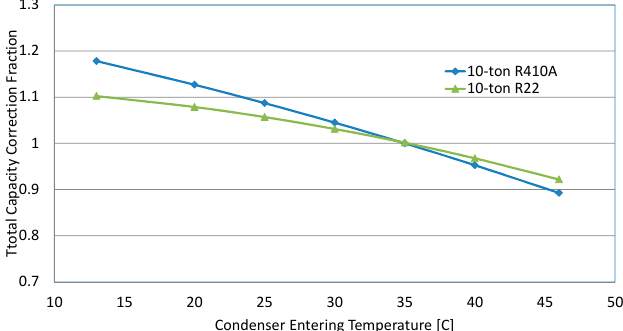
Figure 2. Total cooling capacity correction ratios of R-22 and R-410A varying with outdoor air dry bulb temperature and fixing indoor wet bulb at 67 °F (19.4 °C).